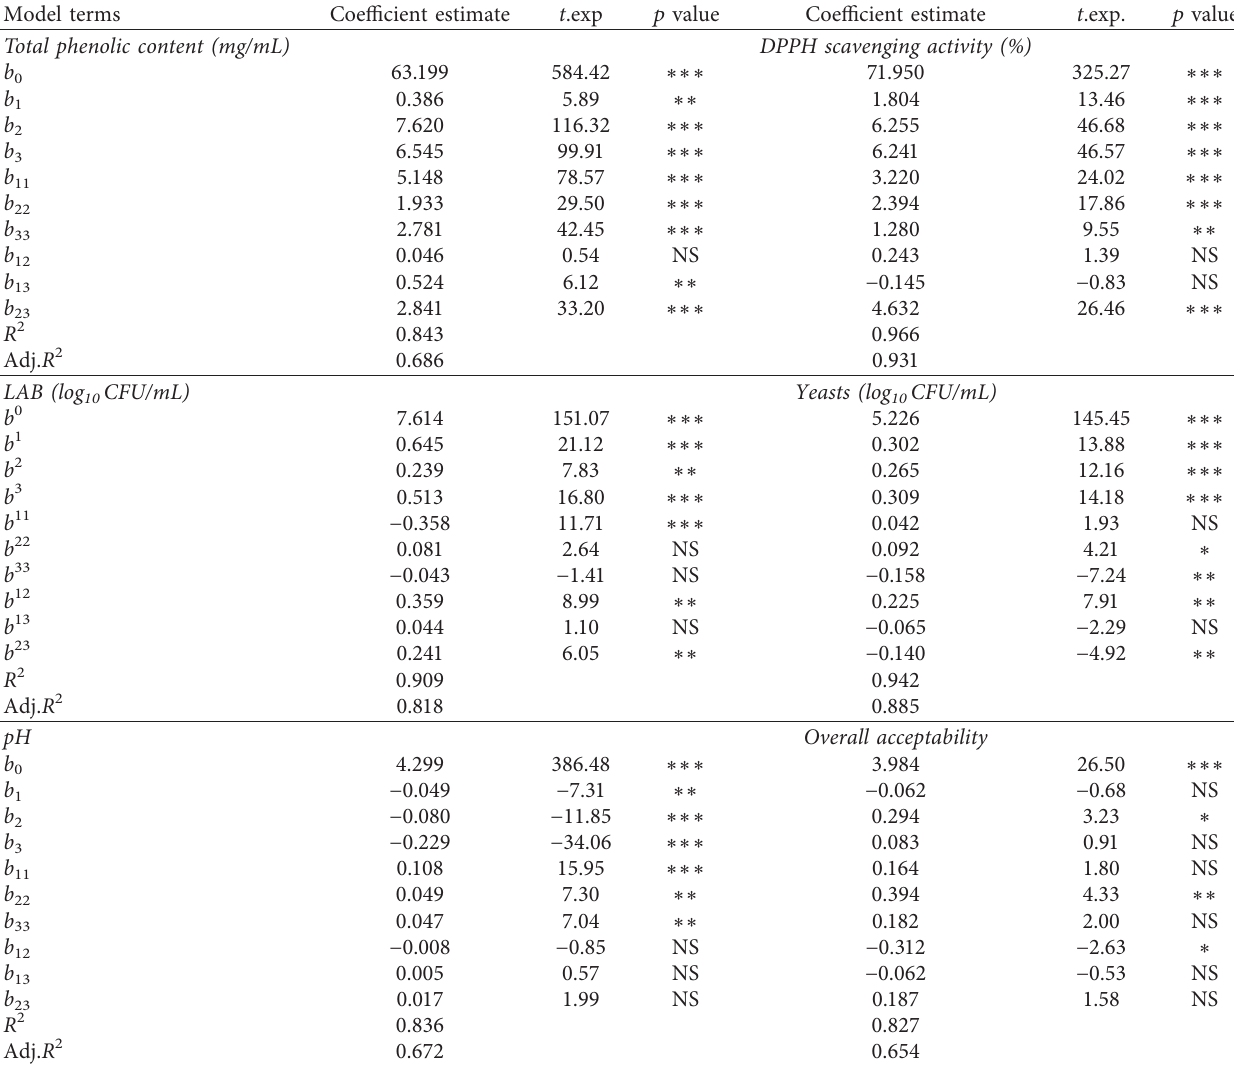
Table 4: Analysis terms for the quadratic model representing the investigated responses (TPC, DPPH (%), LAB and yeasts’ number, pH, and overall